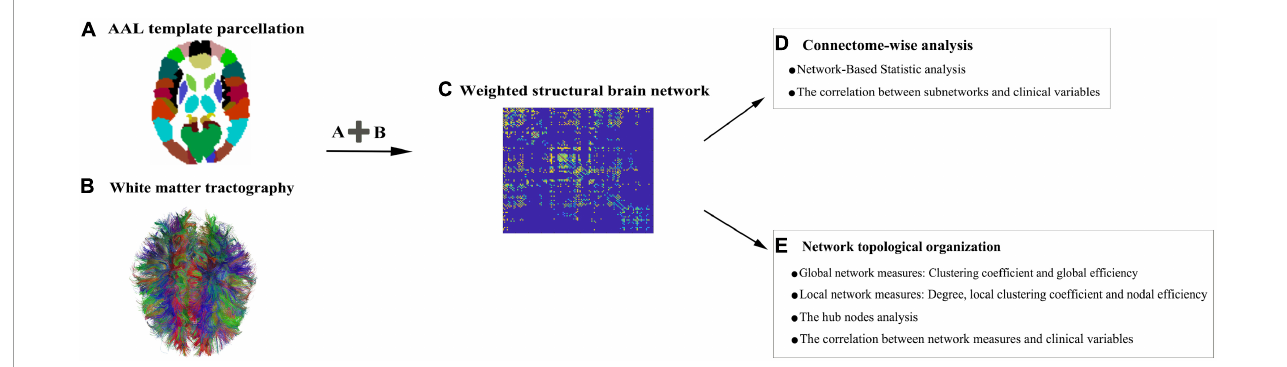
FIGURE1 A flowchart for the construction of structural brain networks. (A) The 90 nodes of the brain network obtained from the automated anatomical labeling (AAL) atlas. (B) White matter (WM) fiber information prepared to check which pairs of nodes remain connected. (C) Region-based information extracted from the abovementioned image data. All pairwise connections between the nodes are calculated to generate a connection matrix. (D,E) A list of network analysis entries that are